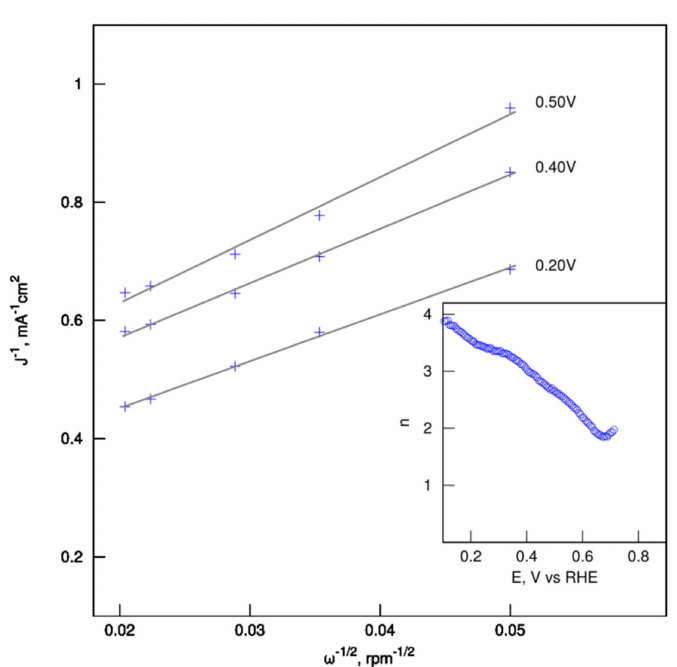
Figure 9. LSV measurements at a scan rate of 10 mV s − 1 for CH_K. The Koutecky–Levich plots (J − 1 vs. ω − 1/2 ) of the catalyst were obtained from LSVs according to the current at various potentials and all lines show good linearity (Figure 10). The electron-transfer number calculated from the slope of Koutecki–Levich plots for the electrode potential in the range from 0.1 to 0.6 V is not constant and decreases from 4 at low overpotential to ca. 2 at 0.6 V.